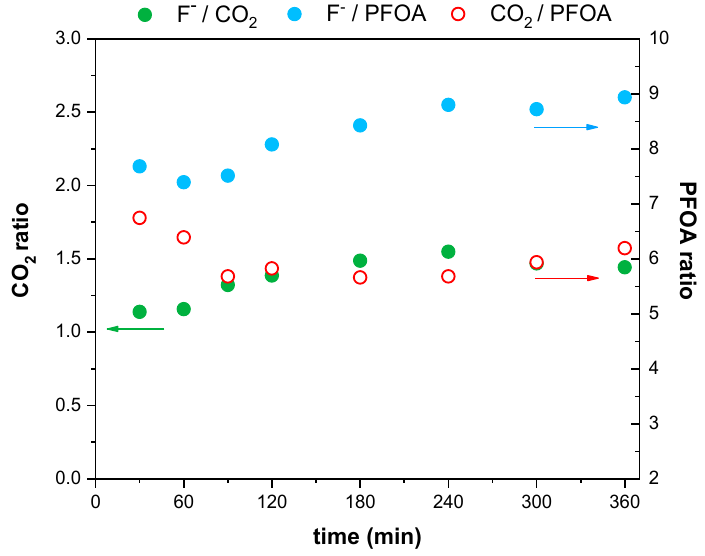
Figure 3. Variation of fluorine ions (full symbols) and carbon removal (empty symbols) during electrolysis with respect to carbon removal and degraded PFOA. Operating conditions: [PFOA] 0 : 100 mg/L, j: 7.9 mA/cm 2 , electrolyte: 3.5 mM Na 2 SO 4 , T: 25 °C, pH 0 : 4.